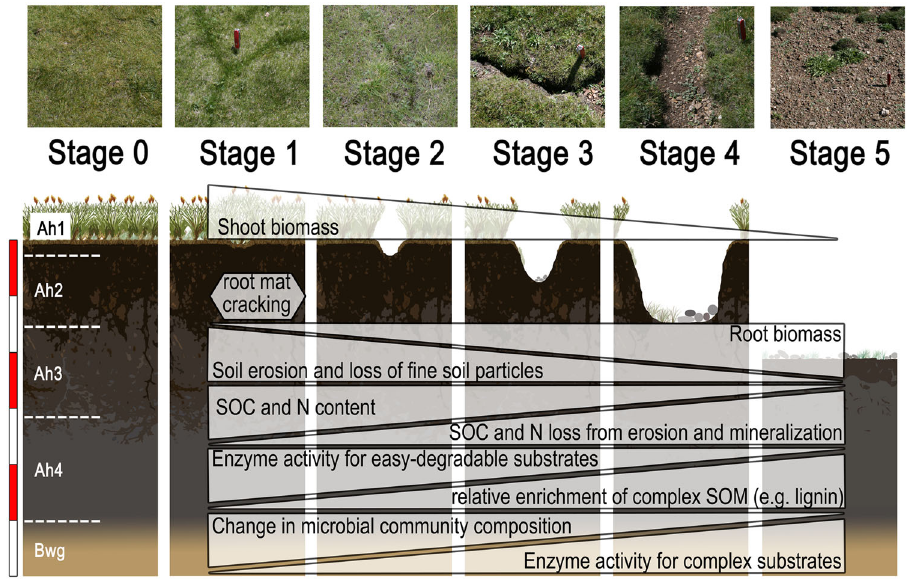
Fig. 5 Overview of the degradation sequence from the intact (S0) to severely degraded (S5) stage, showing the driving forces of degradation. Polygons describe main biotic and abiotic degradation mechanisms with a focus on soil organic carbon (SOC) pools, in accordance with the hypotheses. The white/red scale on the left shows a soil depth of 30 cm in 5 cm